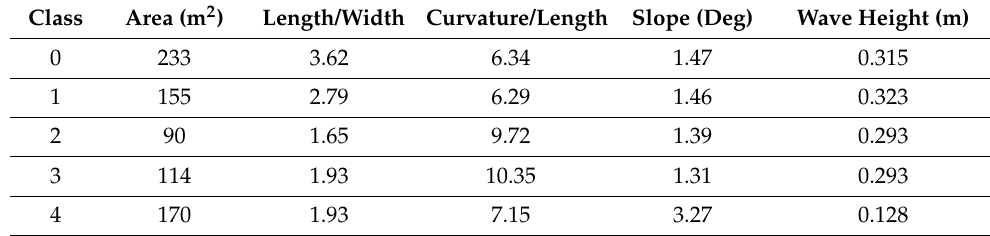
Table 3. Median area, length/width, curvature/length, mean slope, and wave height for each